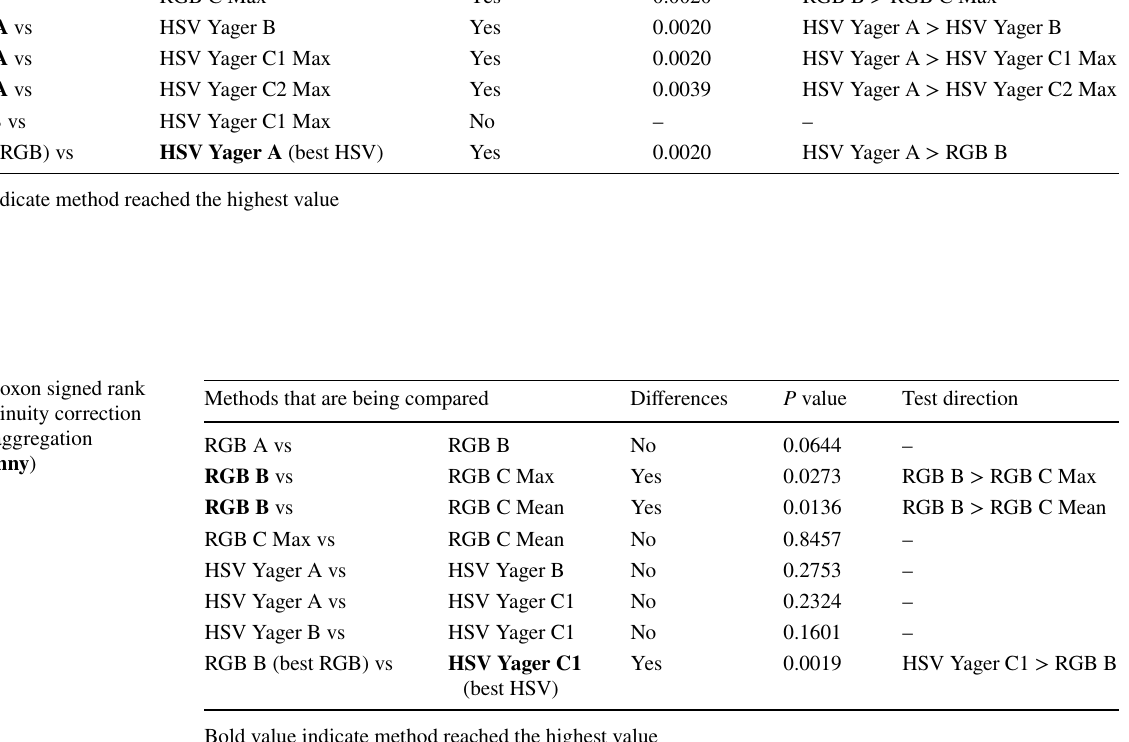
Table 5 Wilcoxon signed rank test with continuity correction between the aggregation methods ( Sobel )